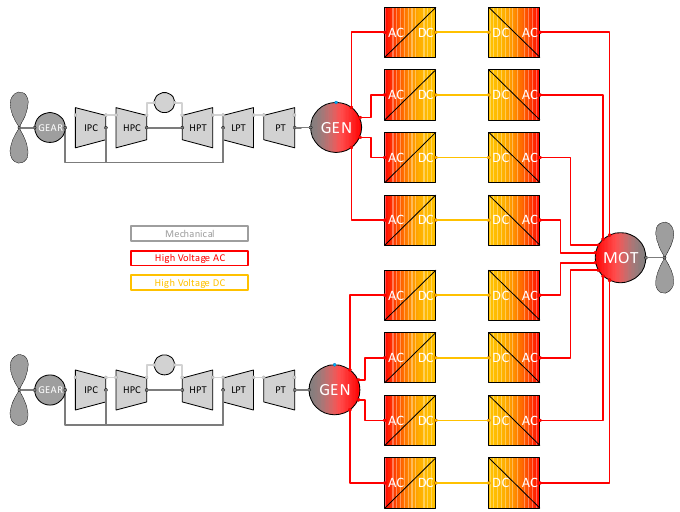
Figure 26. Overall propulsion system architecture (Source [81]).